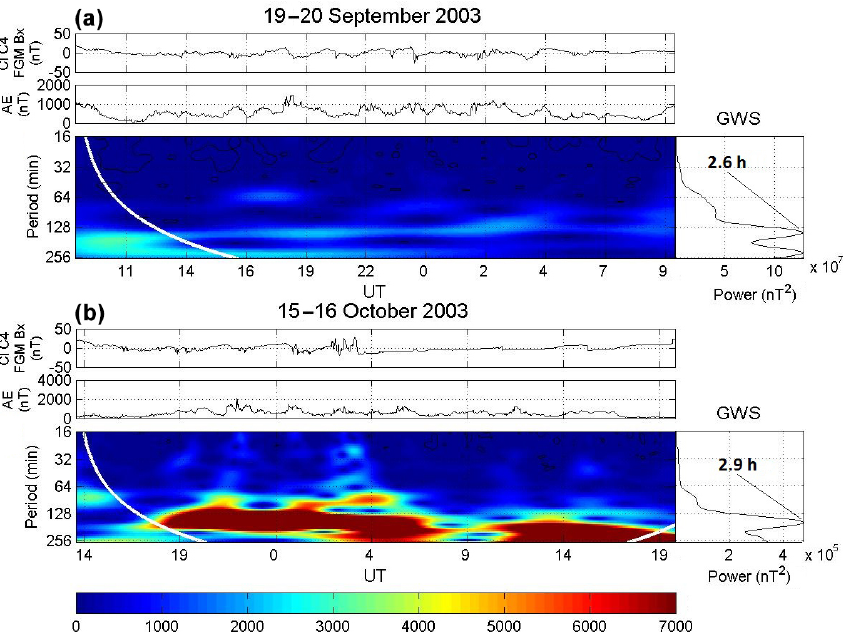
Figure 6. Cross-wavelet spectra between Cluster B x component data and AE index for the (a) 19–20 September 2003 tail crossing (T2) and for the (b) 15–16 October 2003 tail crossing (T5). Otherwise the format is the same as for Fig. 4.